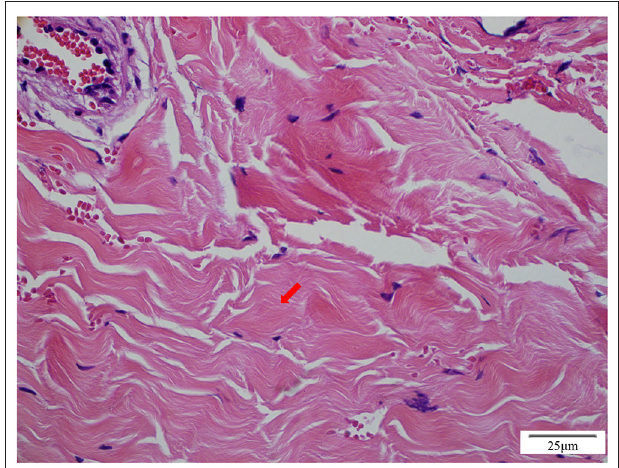
FIGURE 4 | Pathological examination of the pericardium shows hyaline degeneration (red arrow).